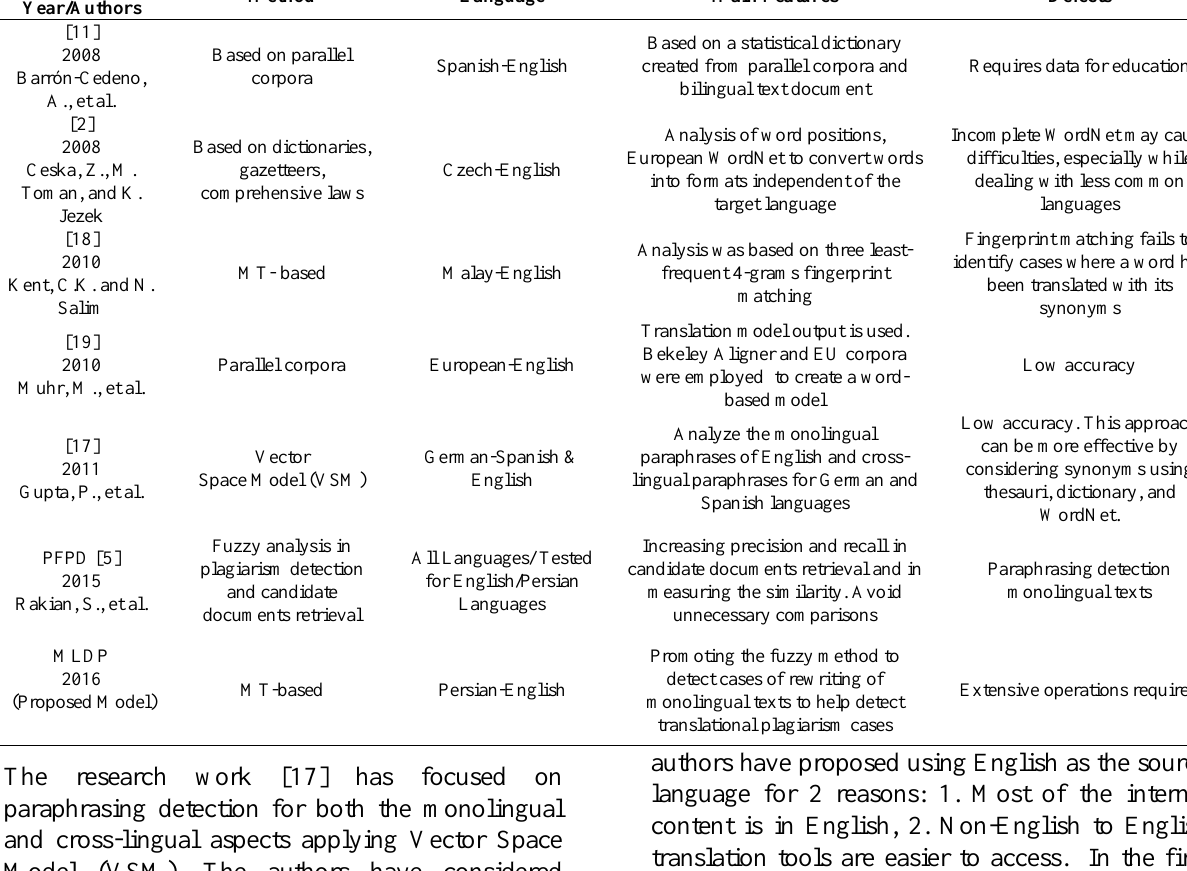
Table 1. Comparison between Previous Research Works on Translational Plagiarism.